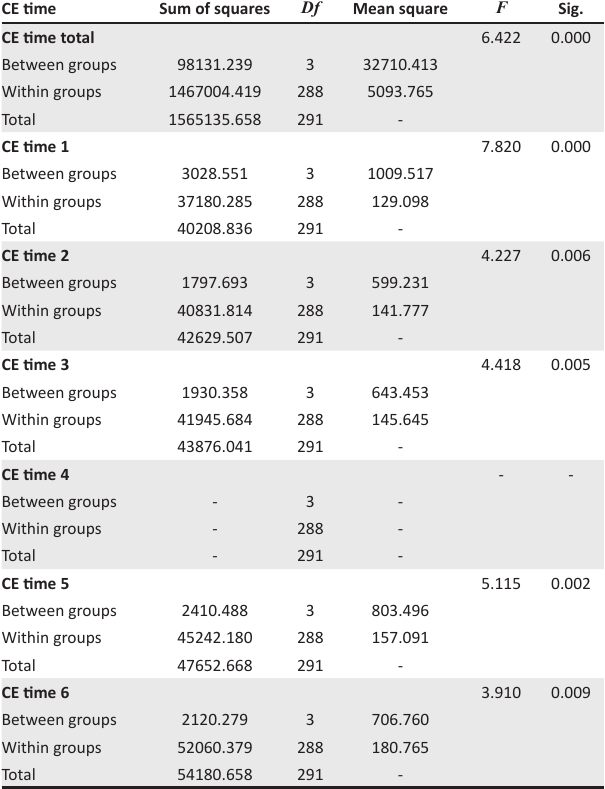
TABLE 5: ANOVA: Comparison of time scores for age groups on the H letter cancellation test.